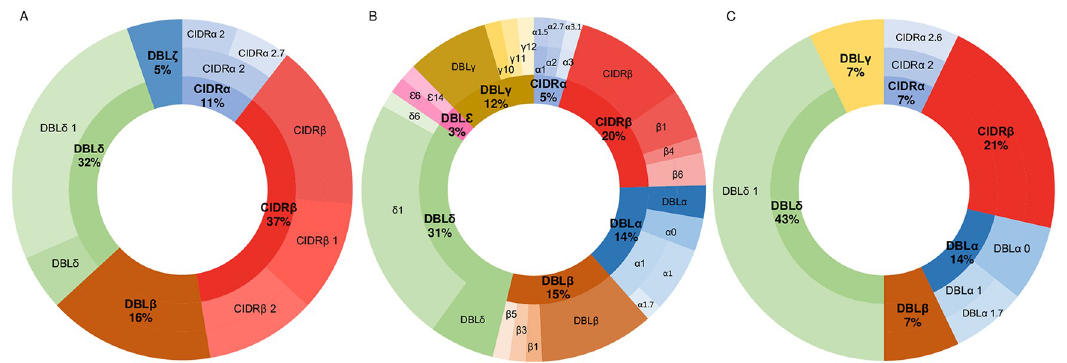
Fig 3. Proportion of peptide corresponding to each PfEMP1 domains and subdomains in association with the clinical outcome. Domains were attributed to each peptide identified in LC-MS/MS. The proportions are displayed for (A) CM patients, (B) SA patients and (C) UM